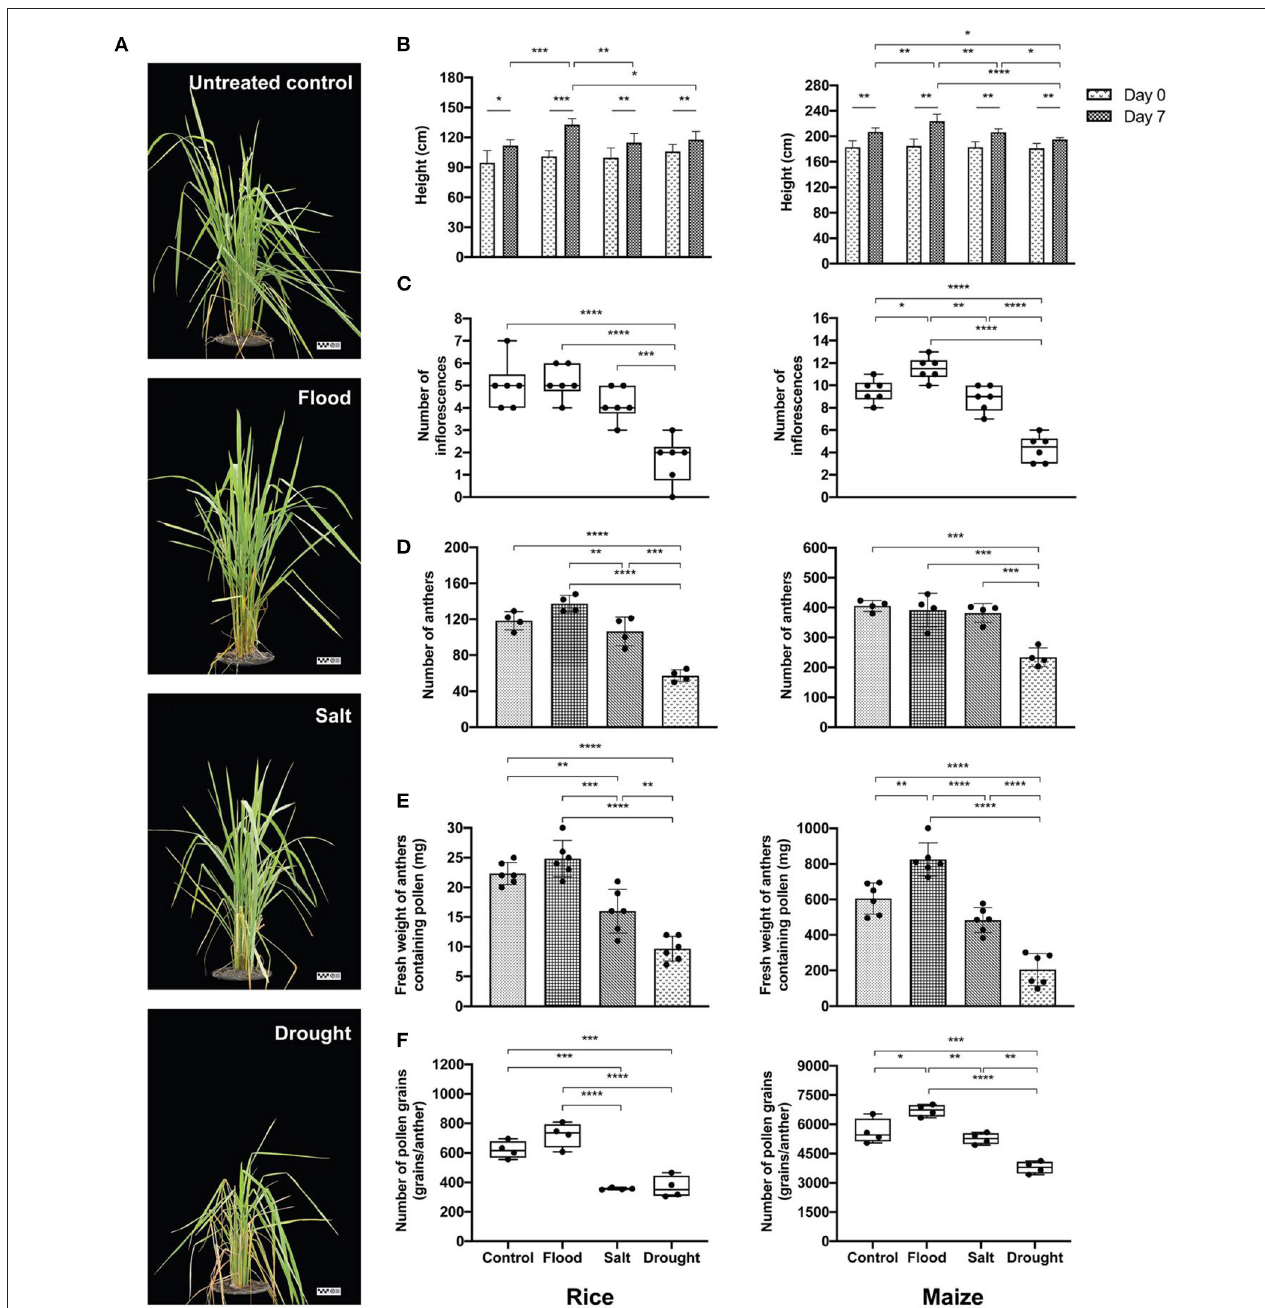
FIGURE 2 | Effects of abiotic stress on experimental plants. Morphological characteristics of untreated control, flood-, salt-, and drought-treated rice were observed at day 7 (the reference scale: 25cm) (A) . Physiological variations of experimental rice (left panel) and maize (right panel) were recorded as follows: plant height at 0 and day 7 (B) , number of inflorescences (C) , number of anthers (D) , weight of anthers containing pollen (E) , and number of pollen grains (F) . Bars with error bars represent mean and SD. Box plots with error bars represent median and interquartile range. Comparing plant heights between 0 and day 7 of each treatment was tested by paired sample t -test. Comparing other characteristics between control, flood, salt, and drought was tested by one-way analysis of variance (ANOVA) (parametric test) with Tukey’s multiple-comparison test. A statistically significant difference was indicated with the following asterisks: *( p < 0.05), **( p < 0.005), ***( p < 0.001), and ****( p <